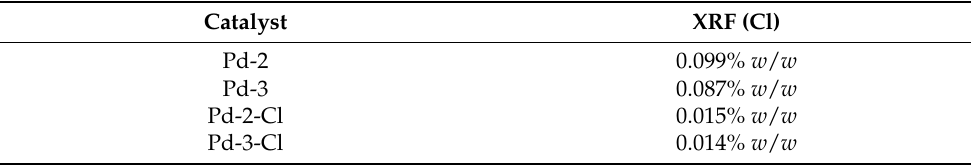
Figure 9. ( a ) Catalytic efficiency of Pd-2, Pd-3 before and after dechlorination. ( b ) T 10 , T 50 and T 90 of Pd-2, Pd-3 before and after dechlorination. Table 7. XRF results of Pd-2 and Pd-3 before and after dechlorination